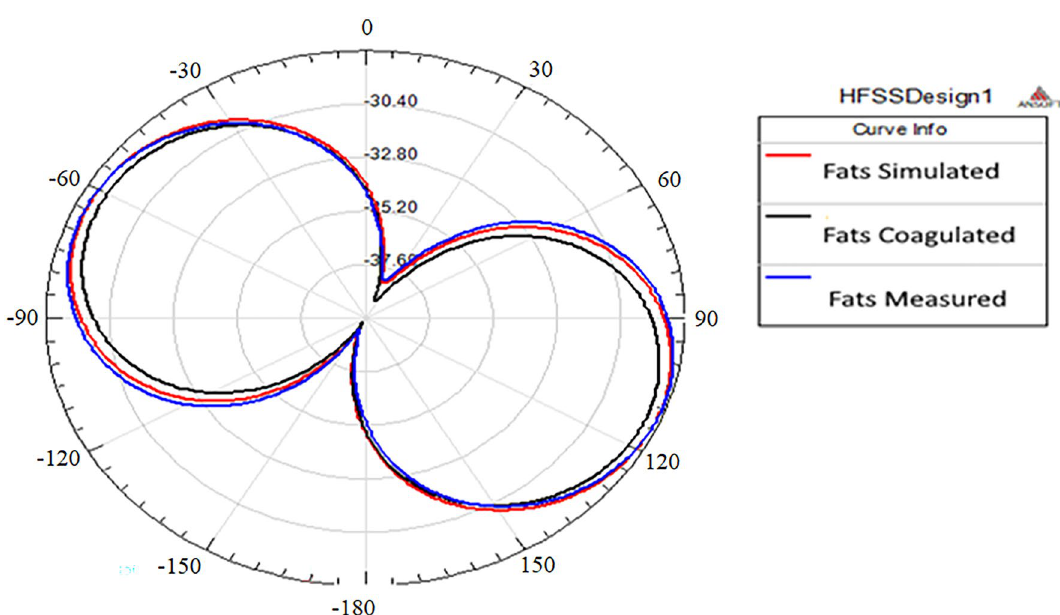
Figure 9. The 3-D radiation patterns for the proposed antenna ( a ) simulation, ( b ) normal fat and ( c ) boiled fat.